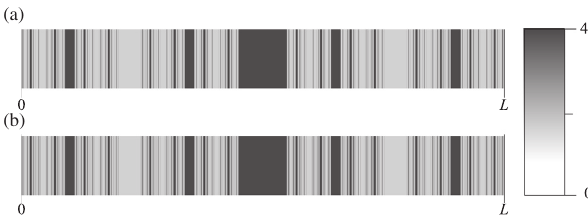
Figure 5. e profile for the 9th and 11th order fractal MTM by MPB. The black and gray color are e 1 and e 2 respectively. (a) 9th order, (b) 11th